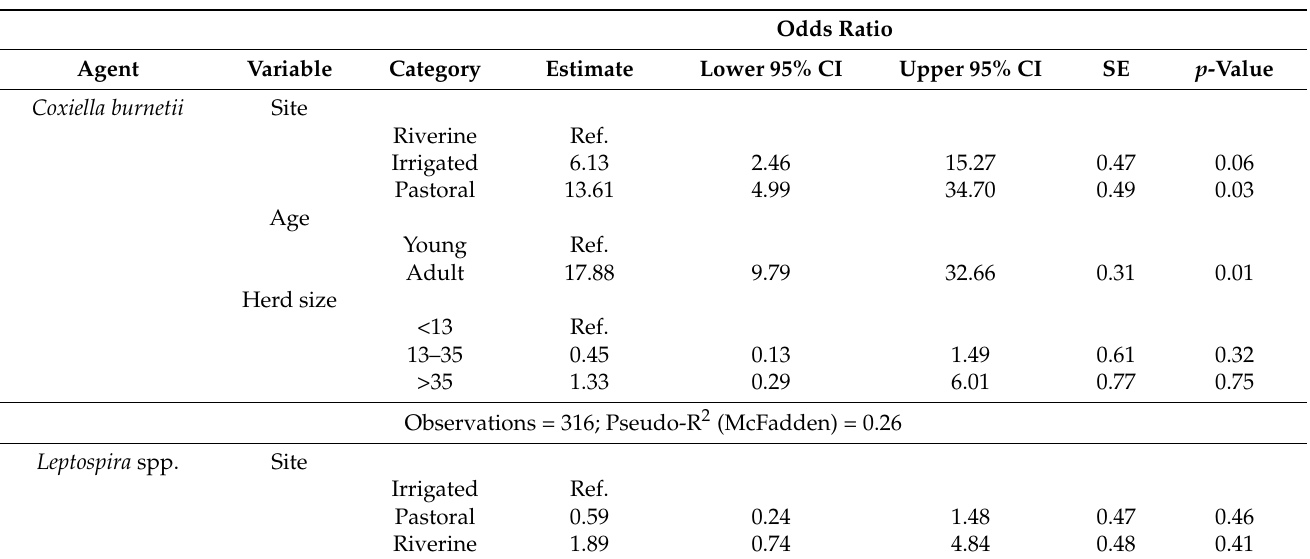
Table 5. Results of the final survey-weighted multivariable logistic regression models for Coxiella burnetii and Leptospira spp. Models represent the direct effects of variables on seropositivity and therefore include intervening variables as determined by the causal